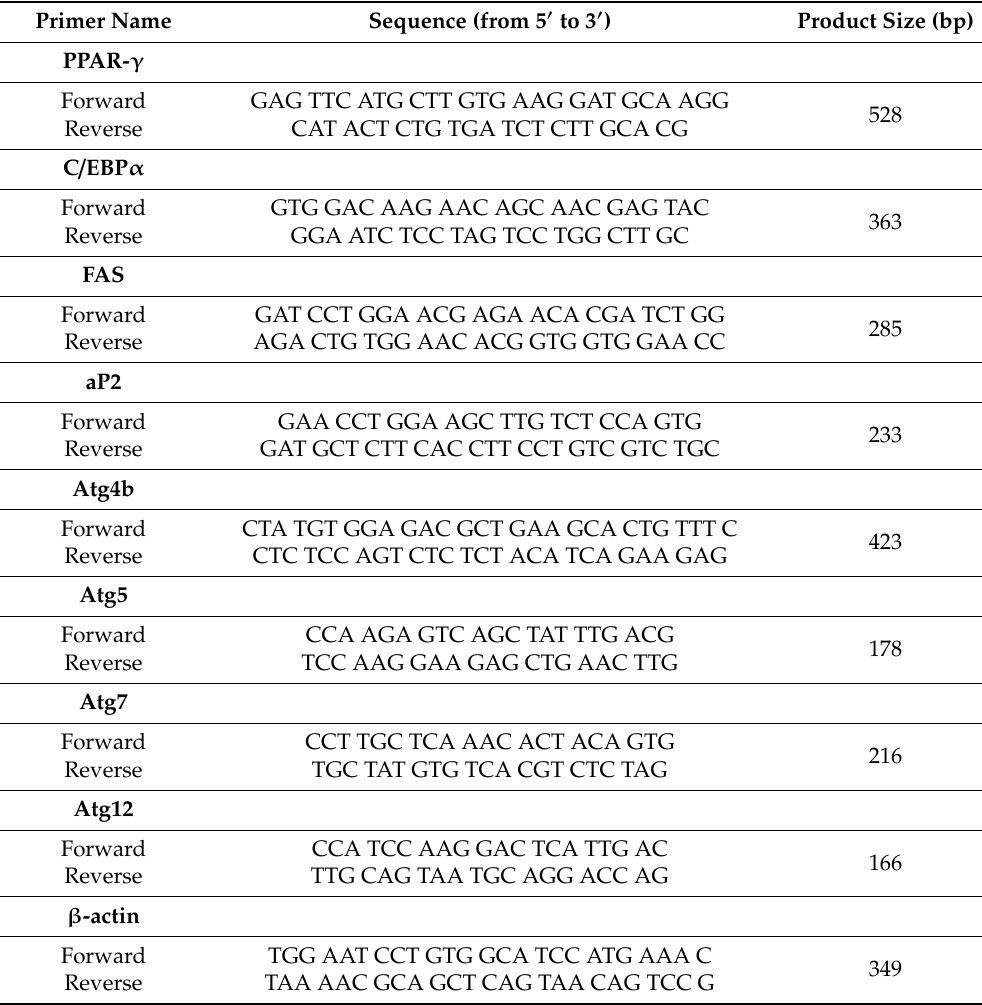
Table 2. Primer sequences for RT-PCR